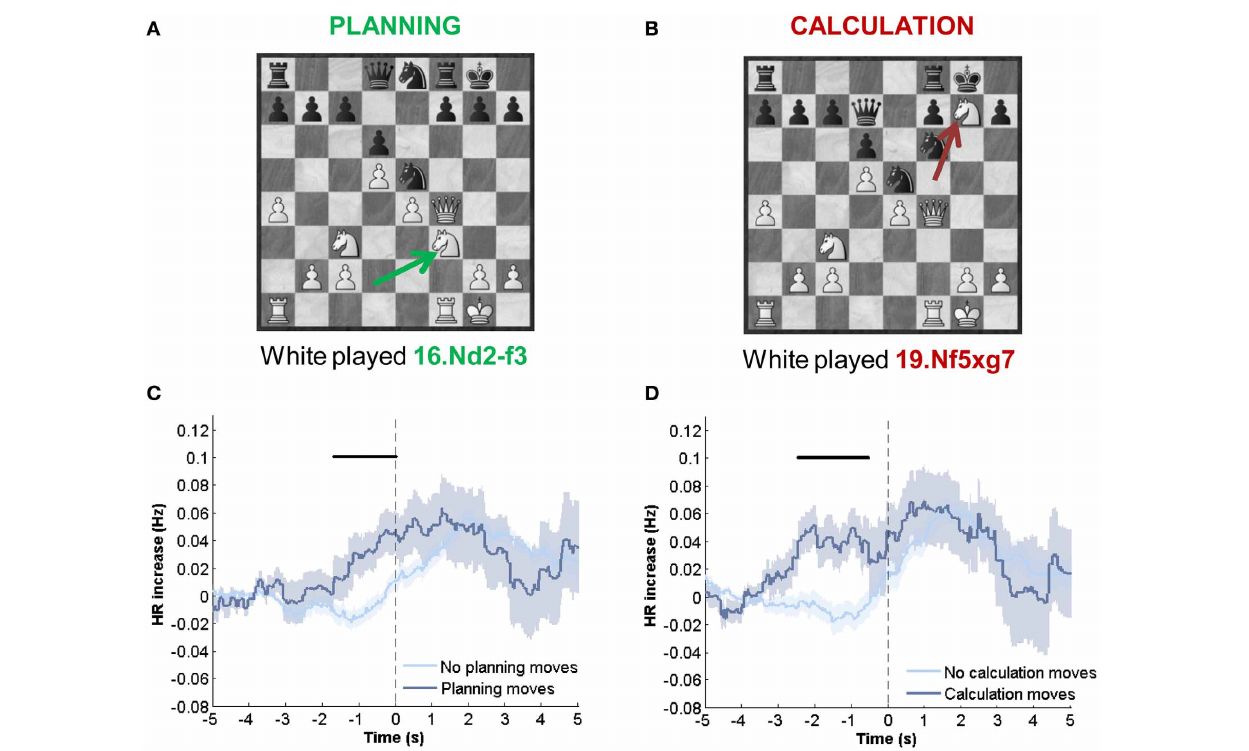
Kg8-g7, 20.Qf4-f6 + Kg7-g8, (a) 21.Rf1-f5 or (b) 21.Nc3-b5 or (c) 21.Ra1-a3). (C) HR dynamics comparison of planning moves and non-planning moves matched by other variables. (D) HR dynamics comparison of calculation moves and non-calculation moves matched by other variables. All moves were no blunders and matching conditions minimized differences in player AT and S. Those moves highlighted as both planning and calculation were not considered. Black bars indicate intervals where differences between temporal series were significant ( p < 0 . 05). Mean ± SEM across all games.